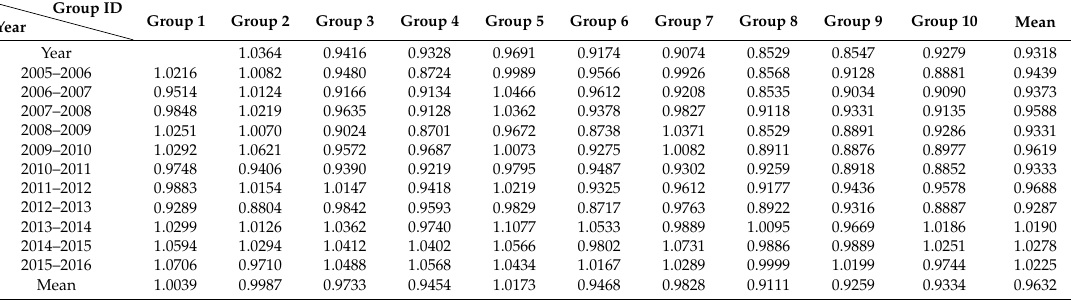
Table 8. Changes in the MMPI in ten major city groups under actual PM 2.5